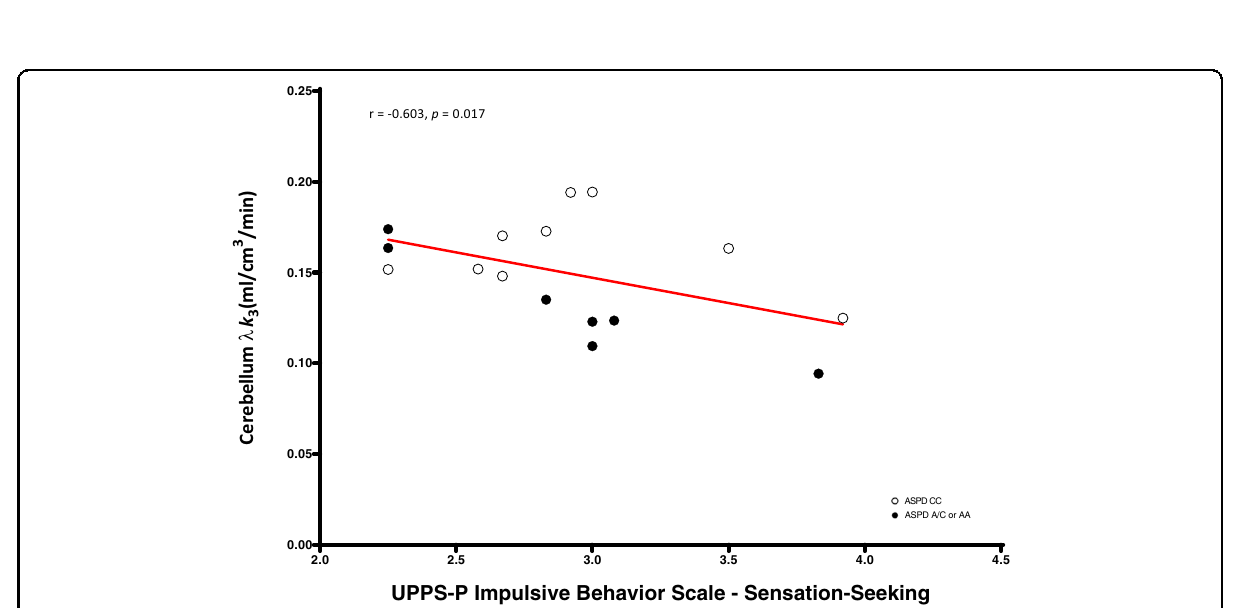
Fig. 1 Lower amygdala fatty acid amide hydrolase λ k 3 in antisocial personality disorder. After controlling for genotype, antisocial personality disorder participants were found to have lower fatty acid amide hydrolase density in the amygdala compared with controls ( p =